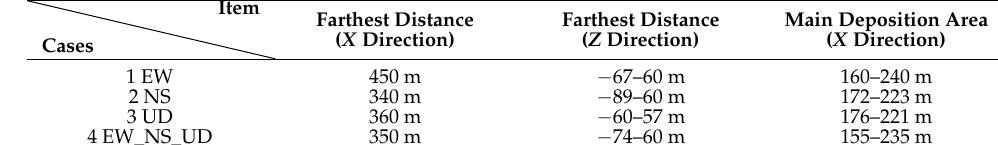
Table 2. Deposition of high-steep rock slide in four cases.